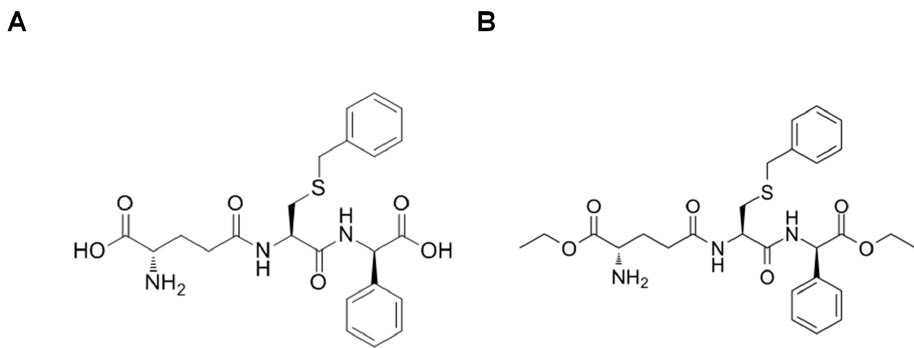
Figure 6. Structure of GSH peptidomimetics ( A ) TLK117 and ( B ) Ezatiostat (TLK199).